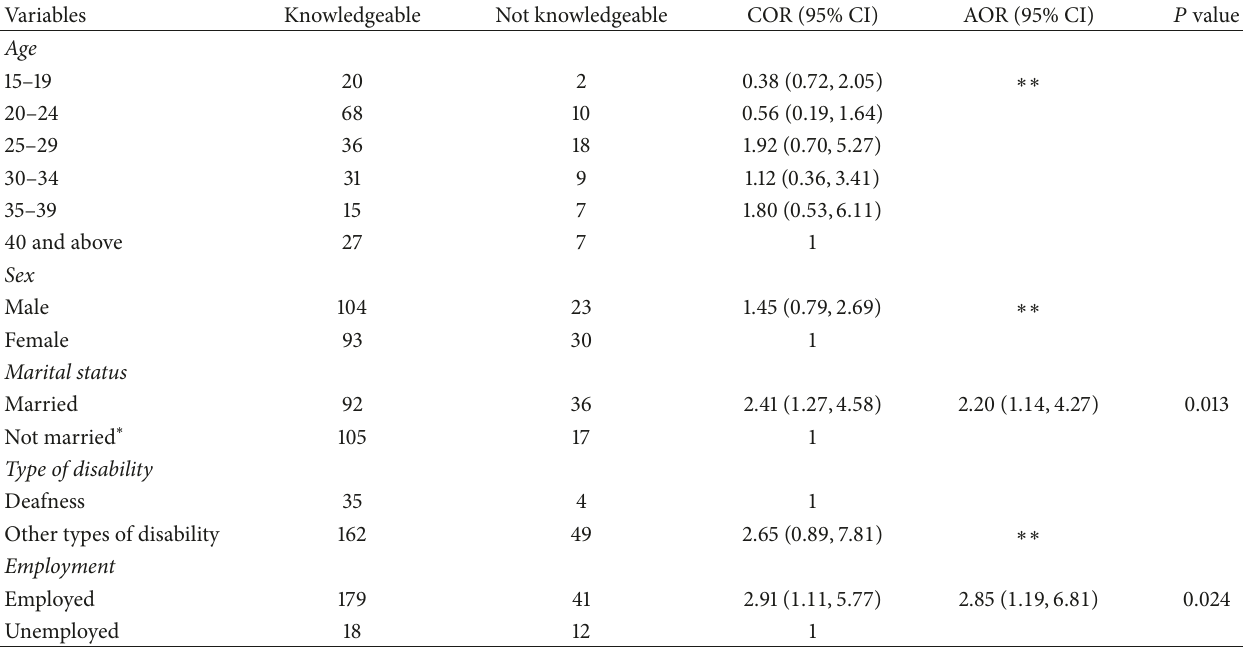
Table 4: Bivariate and multivariate analyses of factors associated with knowledge about HIV/AIDS among disabled people in Hawassa city, southern Ethiopia ( 𝑛 = 250 ).